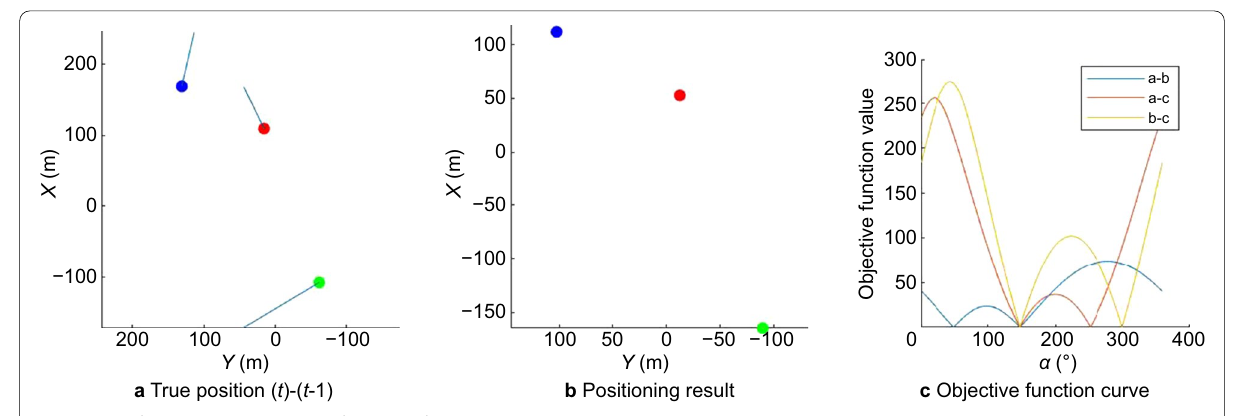
Fig. 13 Random sports scenario, simulation results at time t =